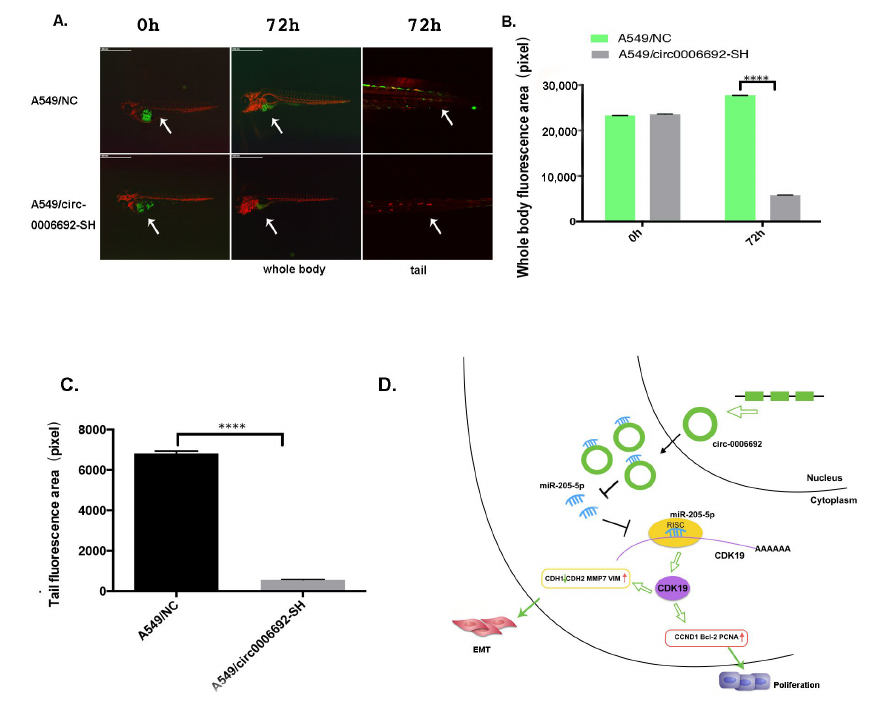
Figure 7. Hsa_Circ_0006692 promoted the growth of lung cancer in zebrafish. ( A ) The fluorescence distribution of lung cancer cells with GFP was observed under stereomicroscope and confocal microscope at different time points; ( B ) The whole body fluorescence area of lung cancer cells at different time points; ( C ) The tail fluorescence area of lung cancer cells at different time